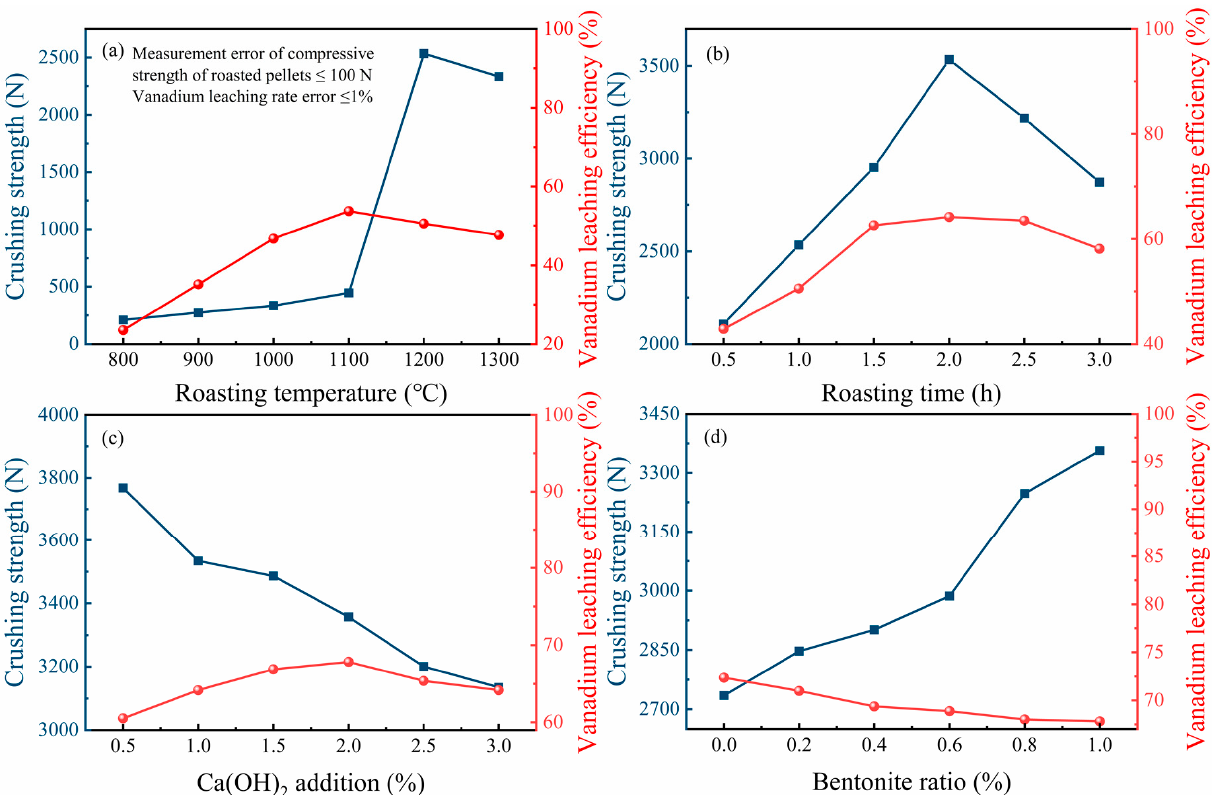
Figure 4. Effect of roasting factors on pellet compressive strength and vanadium leaching rate. ( a ) Effect of roasting temperature; ( b ) Effect of roasting time; ( c ) Effect of calcium hydroxide addition; ( d ) Effect of bentonite